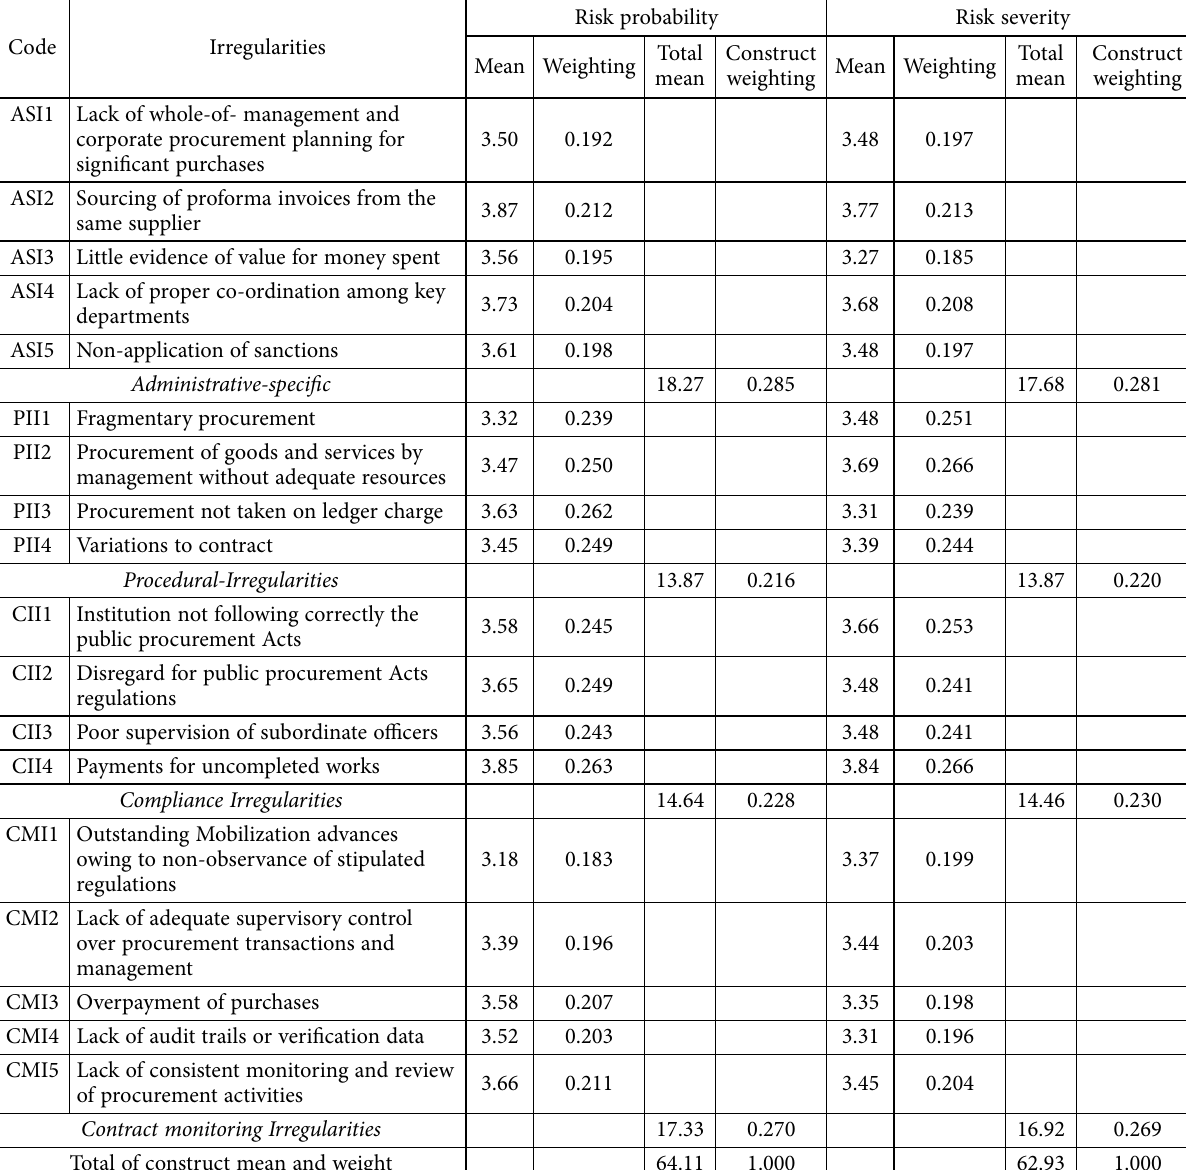
Table 5. Weightings for the activities and stages for the procurement